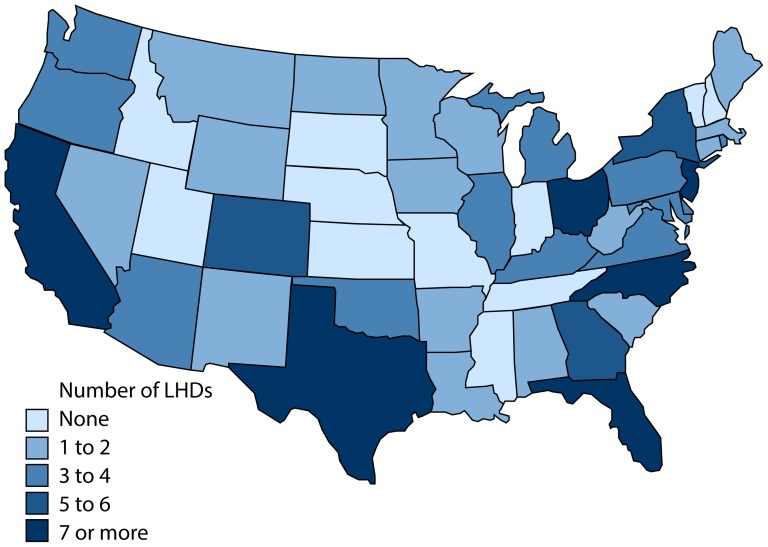
Geographic distribution of participating agencies, by U.S. state.This map shows the distribution of participating agencies across the United States. States with a greater number of participating local health departments (LHDs) are shaded a darker blue. States with the greatest number of participating health departments included California (12 LHDs), Ohio (8 LHDs), North Carolina (8 LHDs), Texas (7 LHDs), Florida (7 LHDs), and New Jersey (7 LHDs). Image developed using data from the National Weather Service and the SPMAP module for STATA 12 (College Station, TX: StataCorp LP) [33], [34].